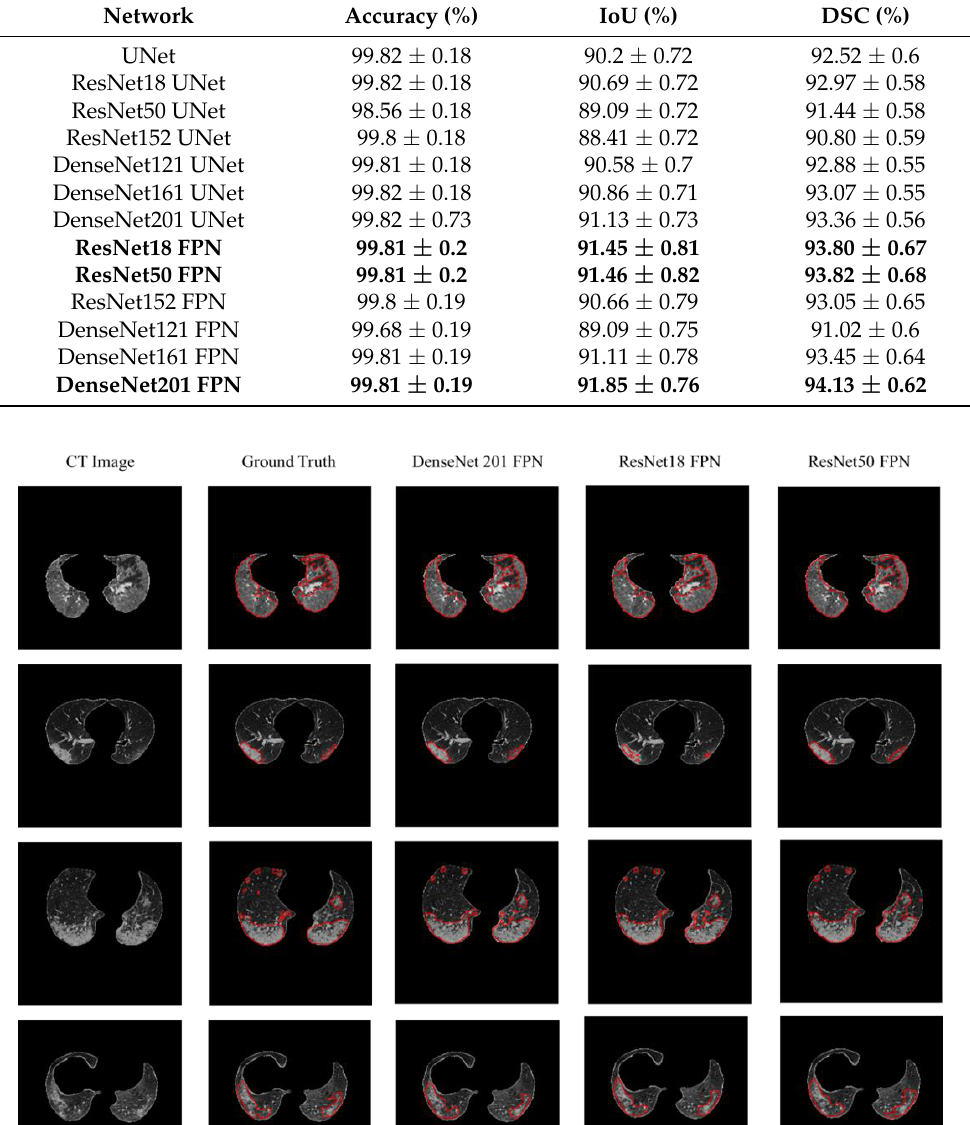
Figure 6. CT image (1st row), ground truth (2nd row), and the lesion segmentation of the best network (row 3) is shown in red.